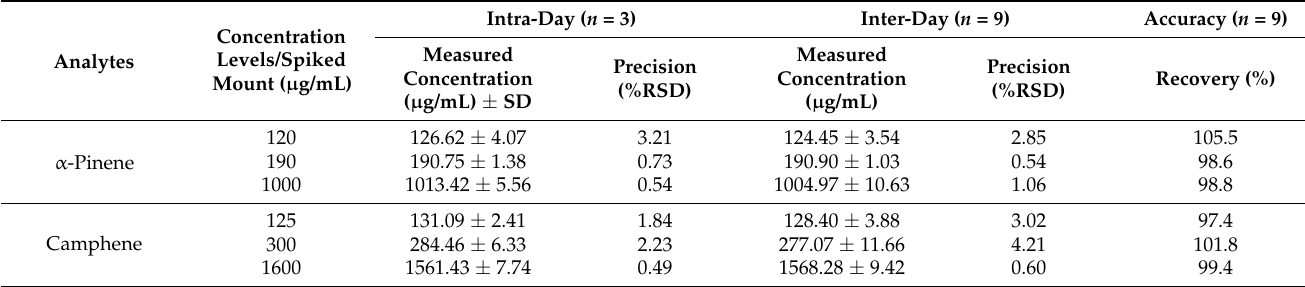
Table 4. Intra-day and inter-day precision and accuracy of the HS-GCMS method for determination of 10 monoterpenoid standards assessed at three different concentration levels ( n = 3) on three consecutive days. Accuracy was expressed as the percentage recovery of 10 monoterpenoid standards in three different concentrations in the placebo Table 3. Correlation coefficient ( r 2 ), linear range, LOD, and LOQ of 10 monoterpenoids in the anti- cellulite emgel analyzed by HS-GCMS.